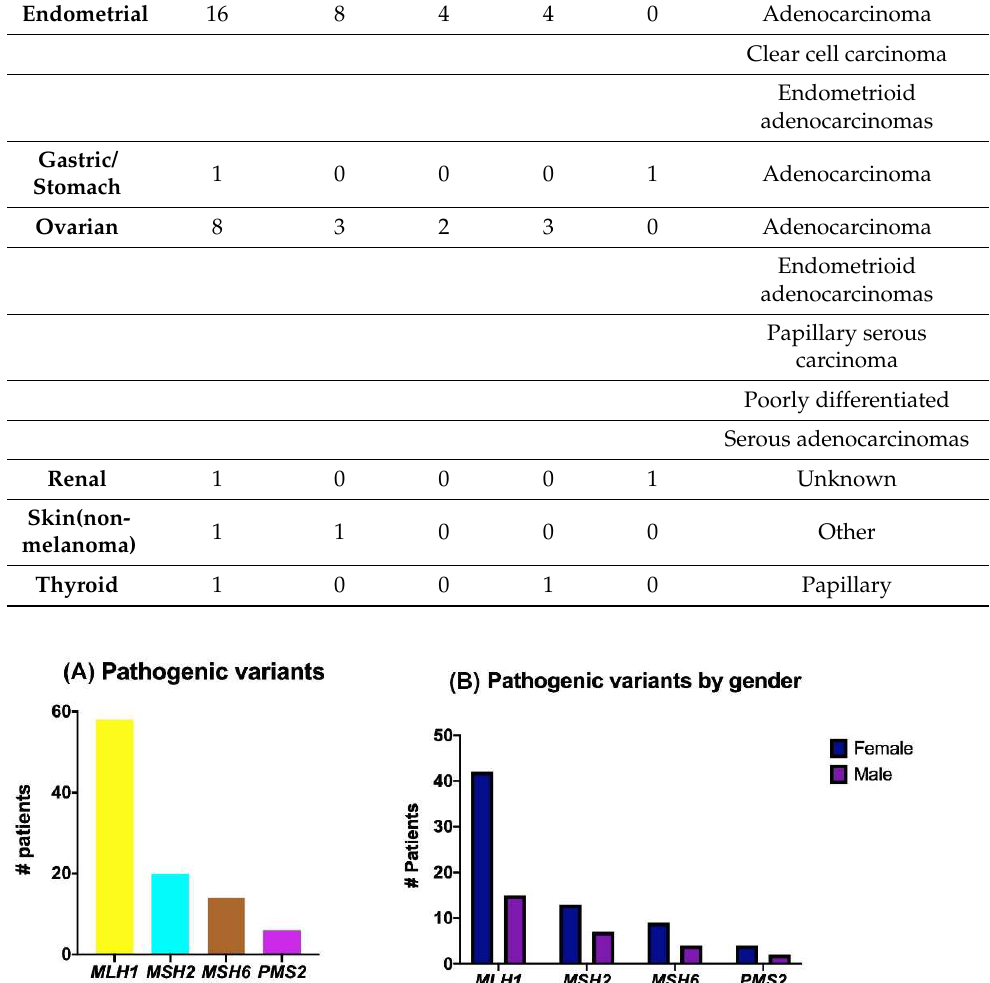
Figure 5. Distribution of pathogenic MMR variants: ( A ) number of pathogenic variants identified by MMR gene; ( B ) pathogenic variants identified by gender.